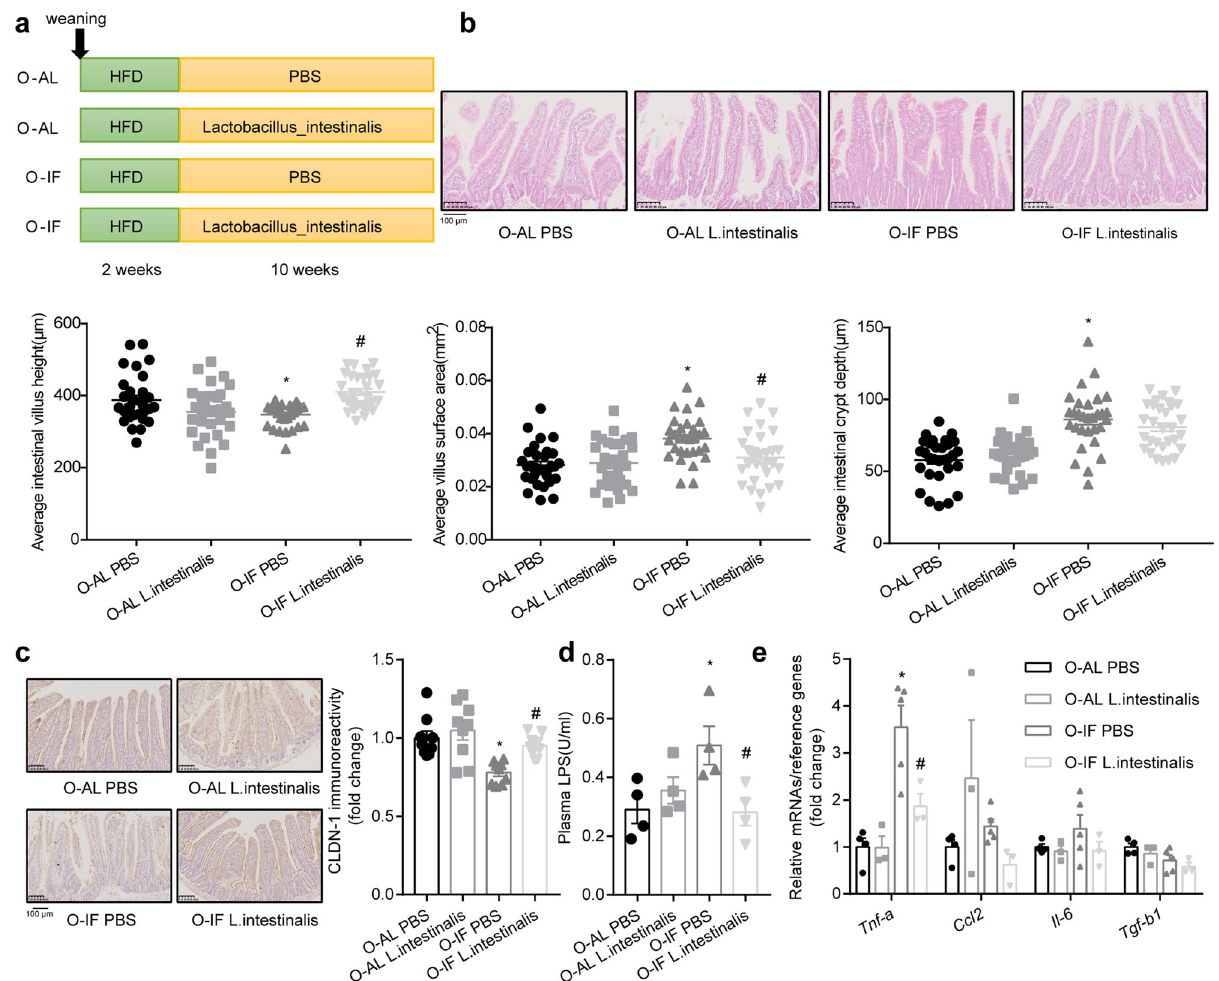
Fig. 3 Lactobacillus_intestinalis restores the intestinal barrier dysfunction in offspring of maternal intermittent fasting mice. a Experimental design. Six- week-old offspring of M-AL group and M-IF group were fed HFD for 2 weeks. PBS or Lactobacillus_intestinalis suspended in PBS at a dose of 2 × 10 8 CFU was administered by oral gavage once a day for 10 weeks. b Intestinal histomorphology. H&E staining of the small intestine and quantitative results of villus height, villus surface area, and crypt depth. c Immunoreactivity of CLDN-1. d Plasma levels of LPS. N = 4. e mRNA levels of in fl ammation related genes ( Tnf-a , Ccl2 , Il-6 and Tgf-b1 ), which were determined by real-time quantitative PCR and normalized to the geometric mean value of reference genes ( Hprt, Rpl32 and Tbp ). Results were expressed as mean ± SEM. * P < 0.05 vs. O-AL PBS. # P < 0.05 vs. O-IF PBS. N = 4 for O-AL PBS, 3 for O-AL L. intestinalis , 5 for O-IF PBS, and 3 for O-IF L. intestinalis ( P = 0.0008) (Fig. 4d), liver steatosis measured by oil red O and H&E staining (Fig. 4e), and adiposity (Fig. 4f).